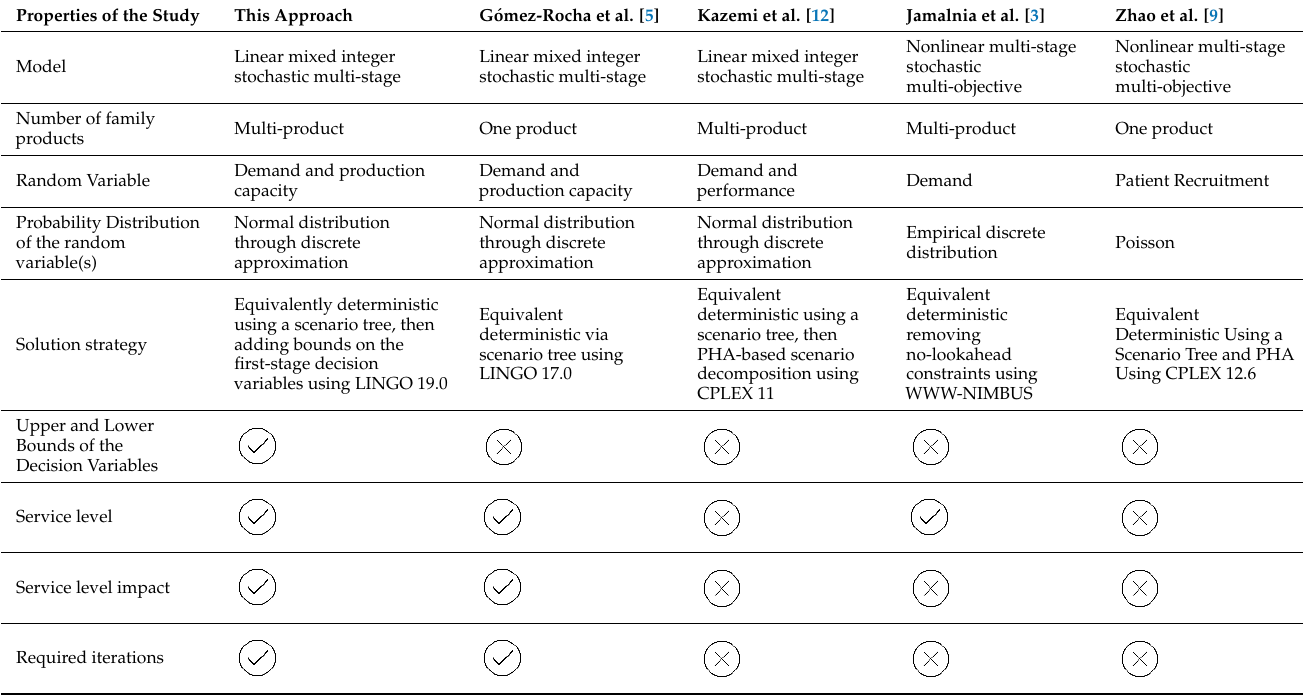
Table 1. Comparison of this study with others about APP solved using stochastic